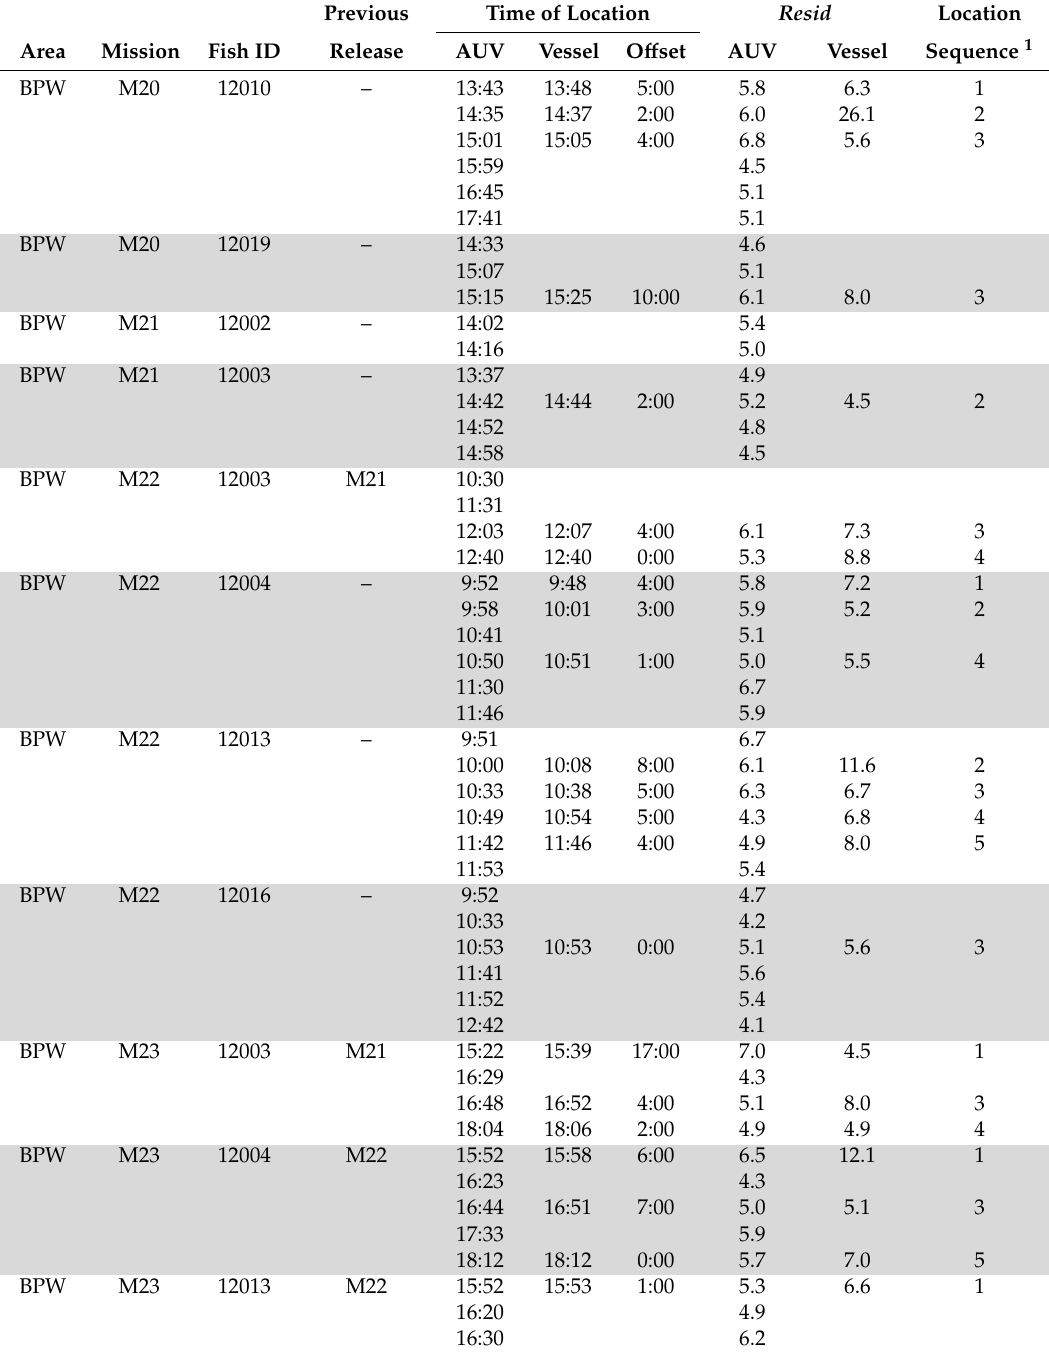
Table A1. Detections of acoustically tagged Chinook salmon located during survey missions conducted concurrently with an autonomous underwater vehicle and surface vessel in marine waters of Big Port Walter (BPW) and Port Walter (PW), Alaska, during 2016. The diagnostic variable used to measure the overall quality of the location solution ( Resid ) and the di ff erence in time between the AUV and paired vessel-based location estimates (o ff set) are